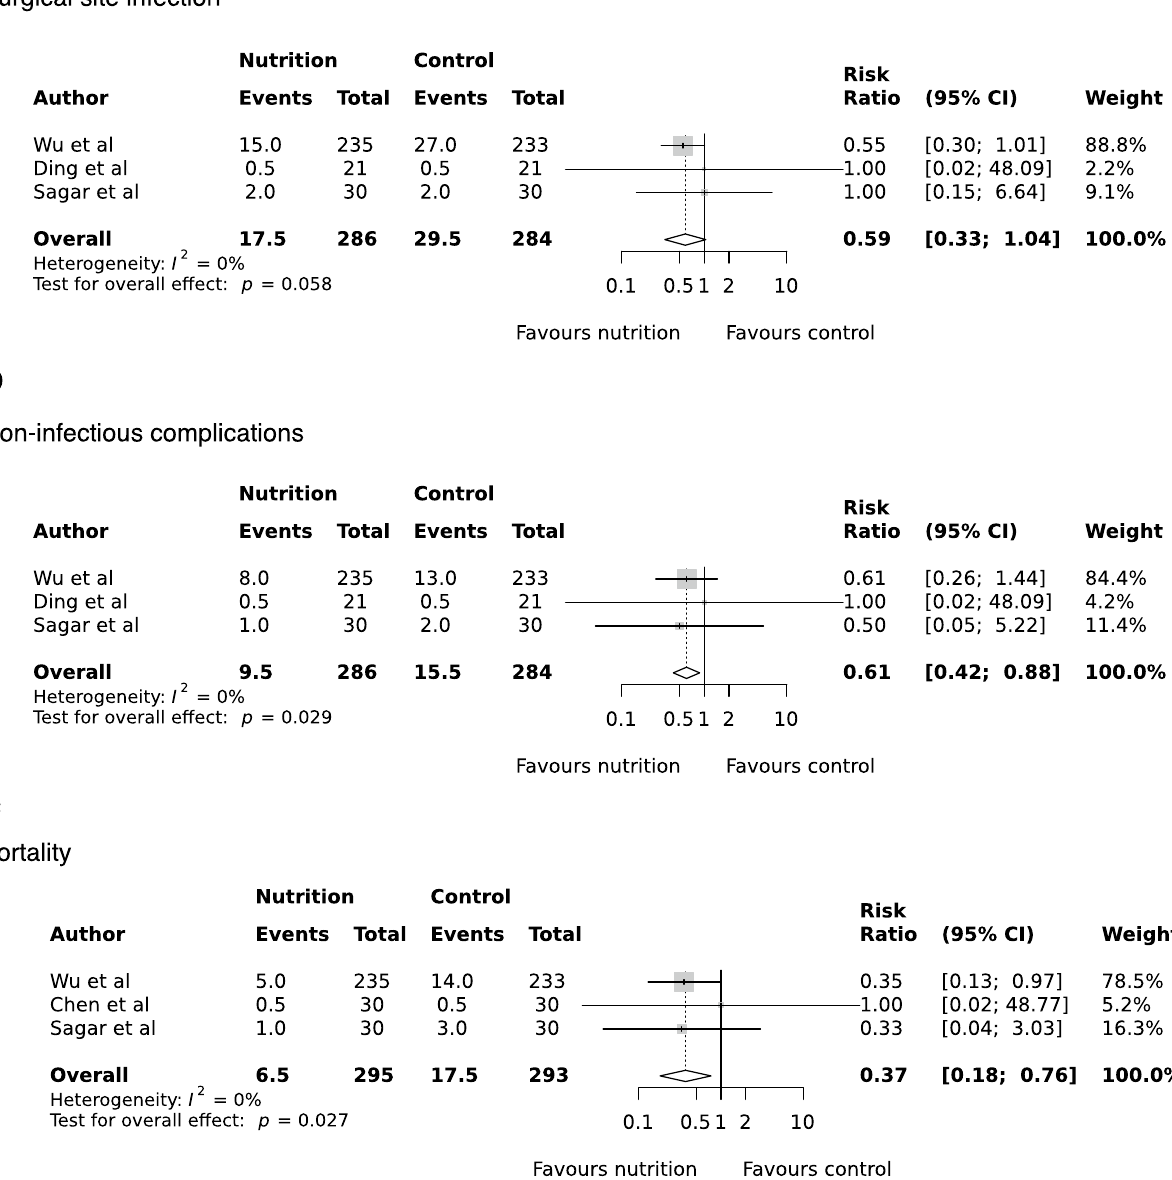
Figure 4. Random-effects meta-analysis of the effects of preoperative oral nutrition on surgical site infection ( a ), non-infectious complications ( b ), and mortality ( C ) in patients undergoing surgery for gastrointestinal